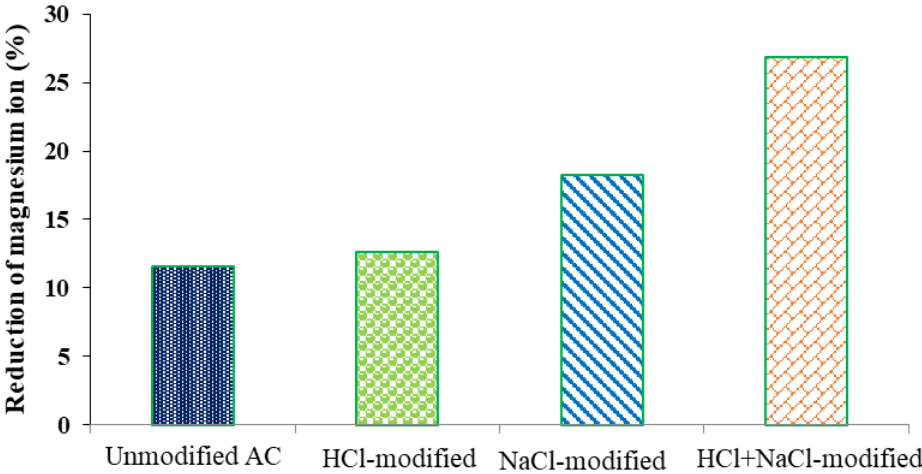
Figure 10. The decrease in magnesium in drinking water by activated carbon and its modified form.